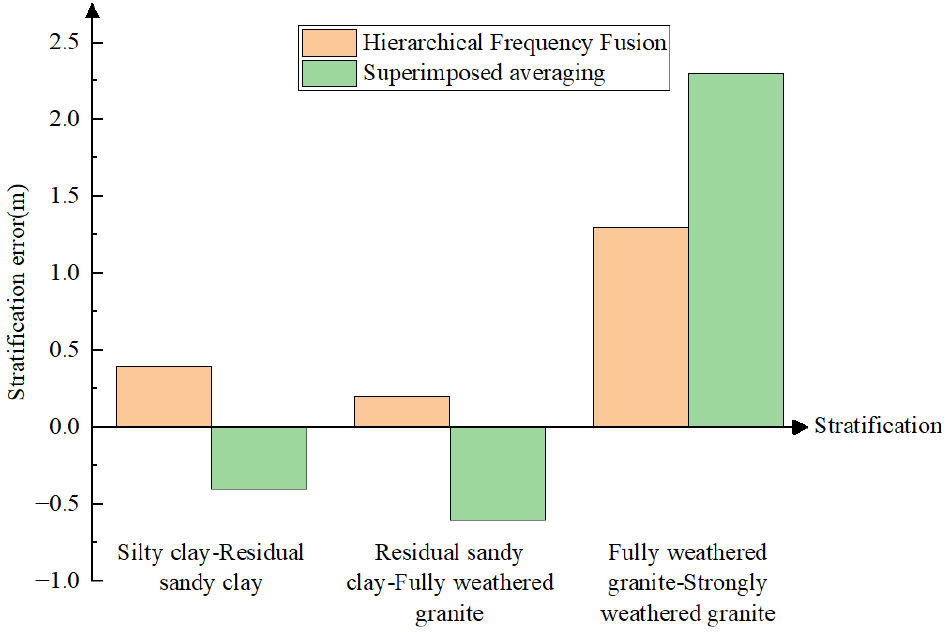
Figure 18. Stra tification error of two methods. Figure 18. Stratification error of two